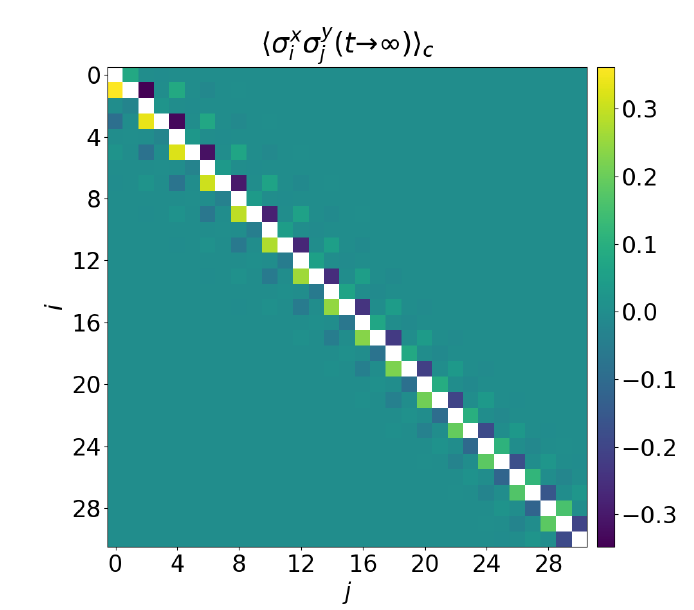
Figure 20: The matrix of X Y connected correlation function of all qubit pairs at the final time, in the simulation of 31 identical qubits in a 1D chain with g shown in Fig. 19. Neighboring qubits close to the left edge have relatively large correlation functions, while correlations between qubits on the right side are weaker, and correlations clearly decay rapidly with distance throughout the